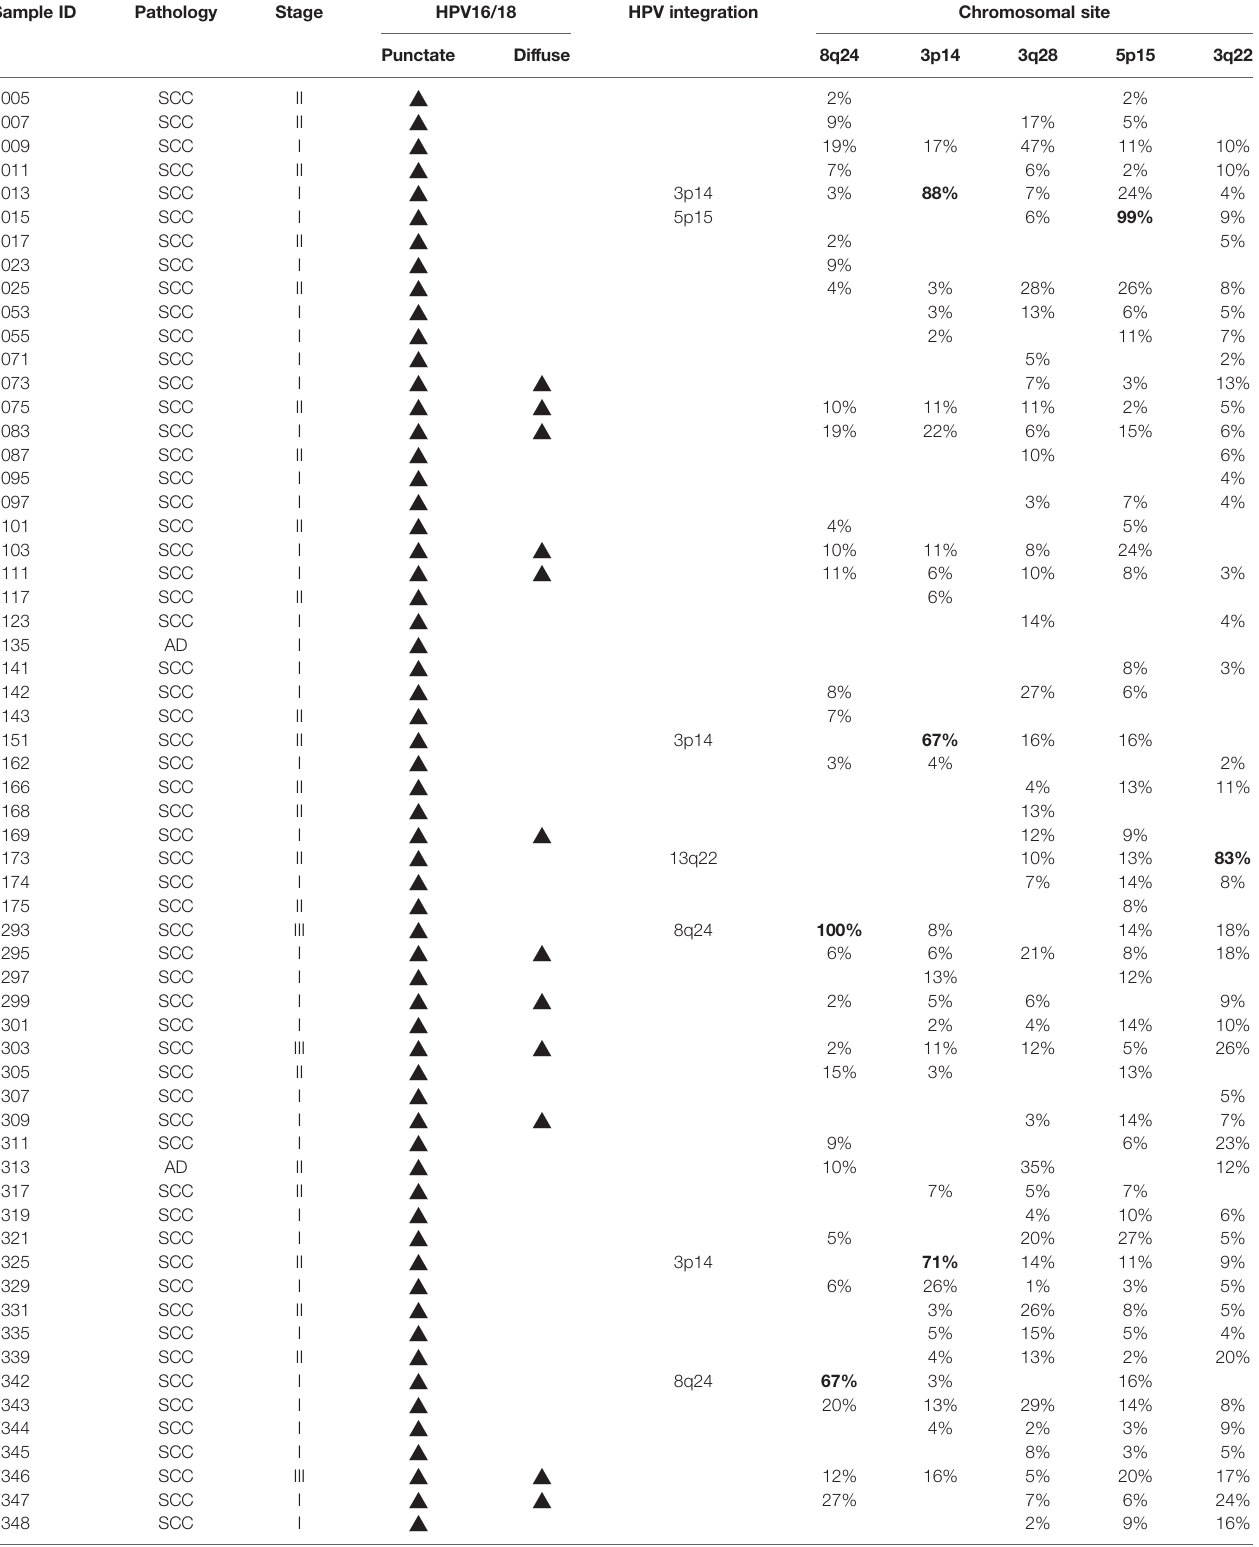
TABLE 1 | Detailed information on HPV integration sites detected by